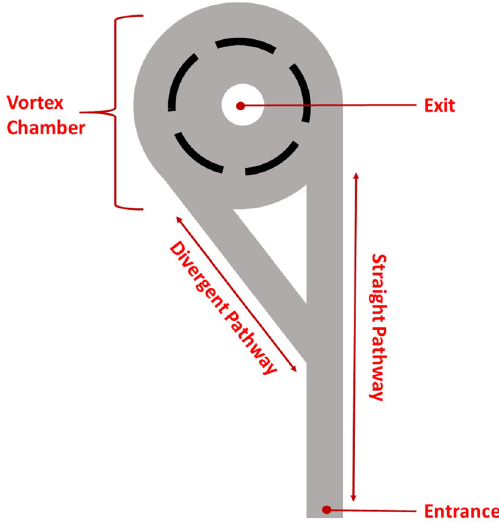
Fig. 3 Simplified Internal Schematic of a Fluidic Diode FCD. Adapted from Fripp et al. (2013)